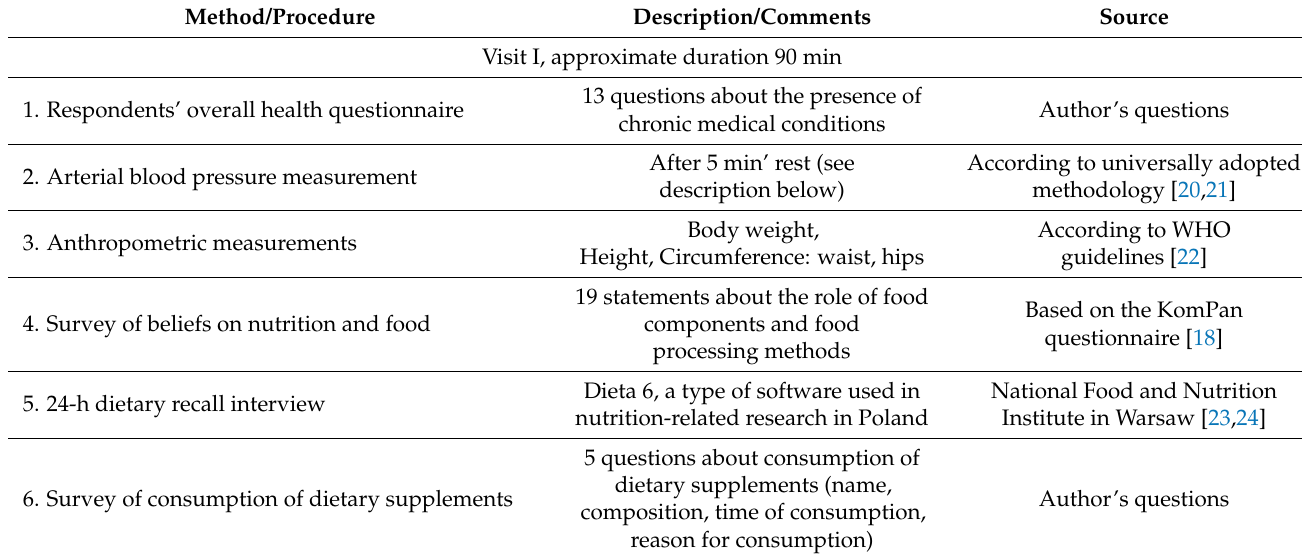
Table 1. Quantitative methods /study procedures employed in the